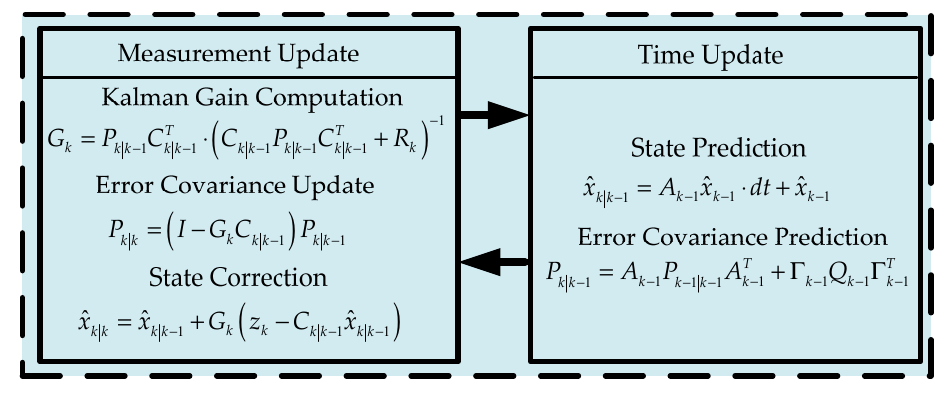
Figure 4. Kalman filter process.